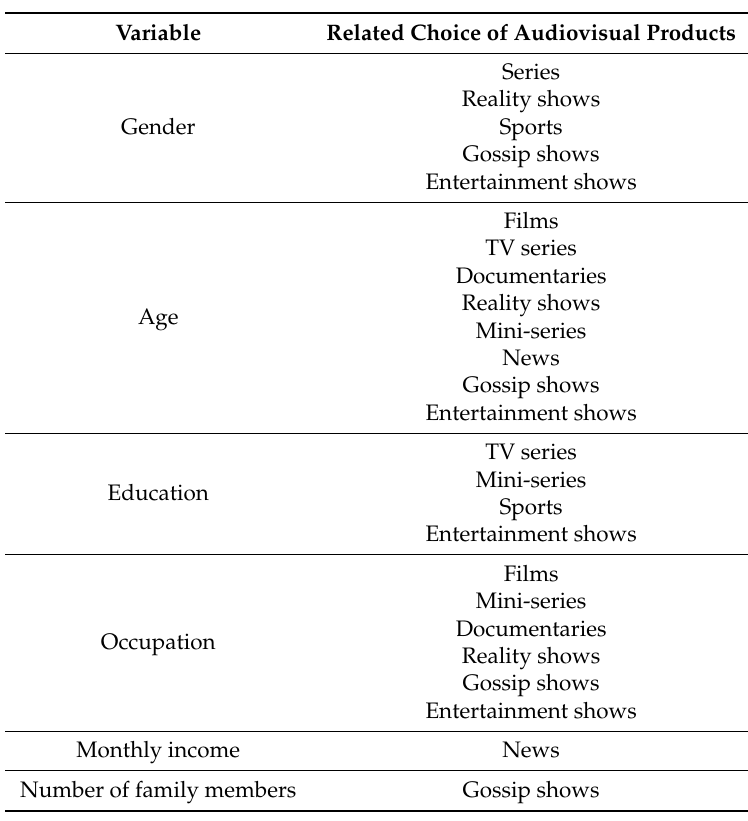
Table 15. Sociodemographic variables that influence audiovisual products